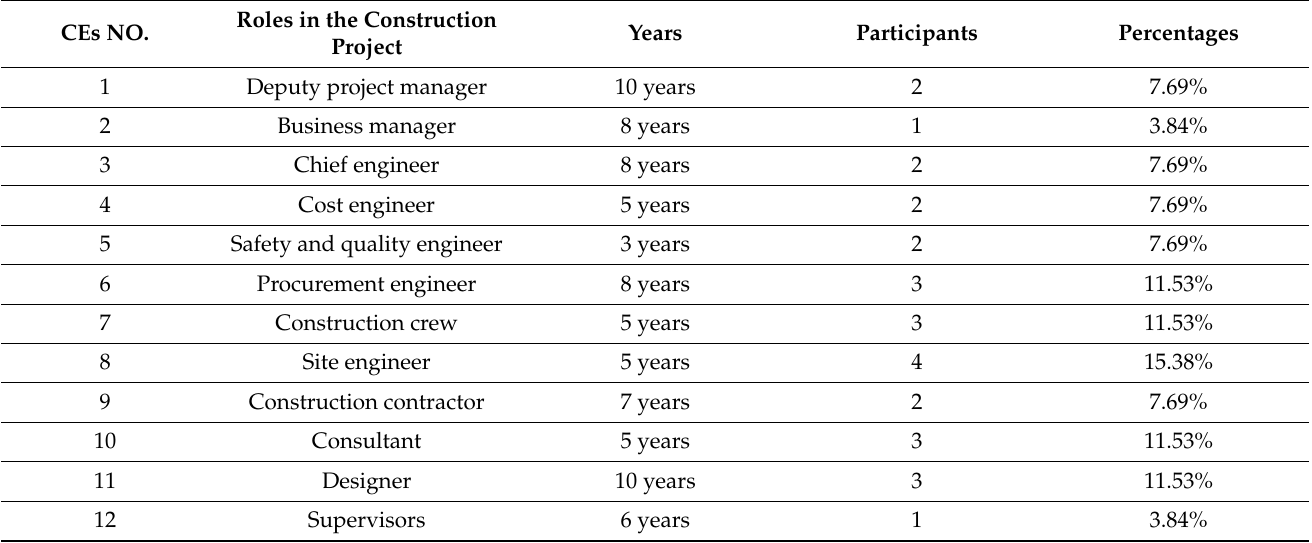
Table 3. Profiles of the